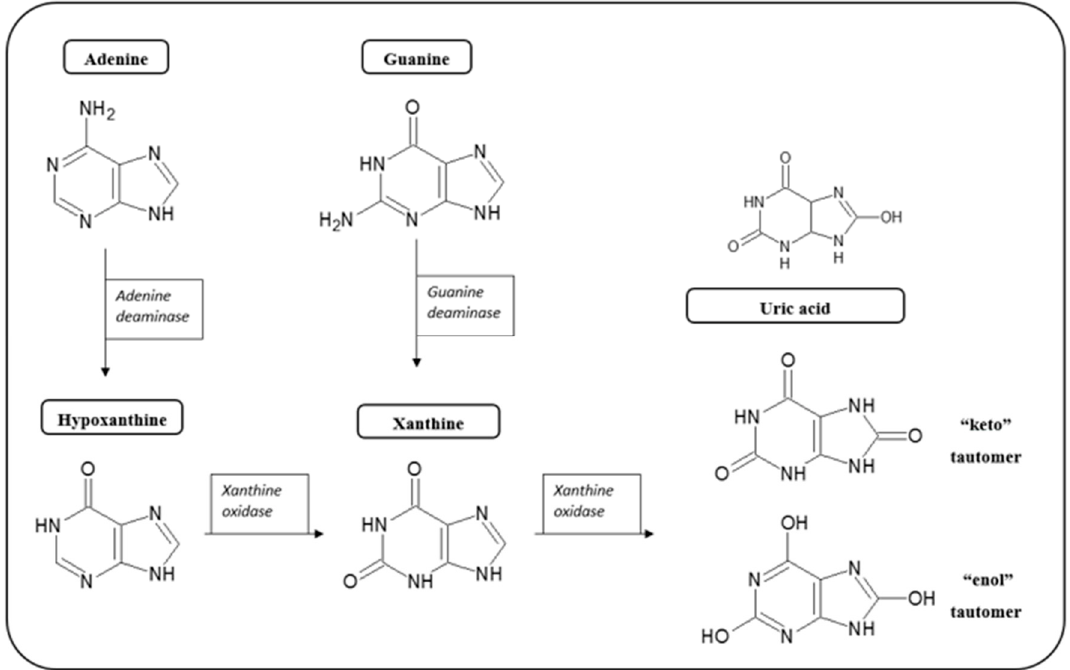
Figure 11. Catabolism of the purines, adenine, and guanine into uric